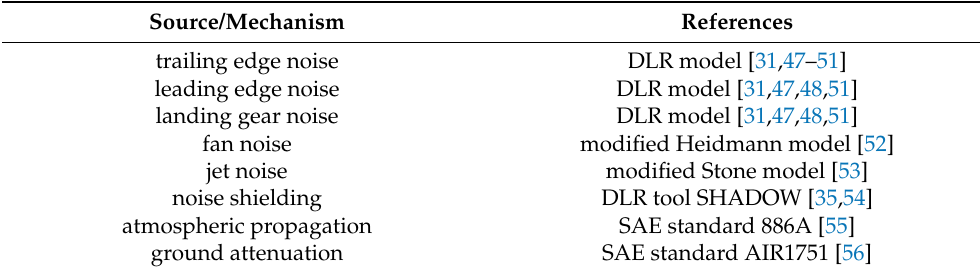
Table 2. Applied simulation methods for noise